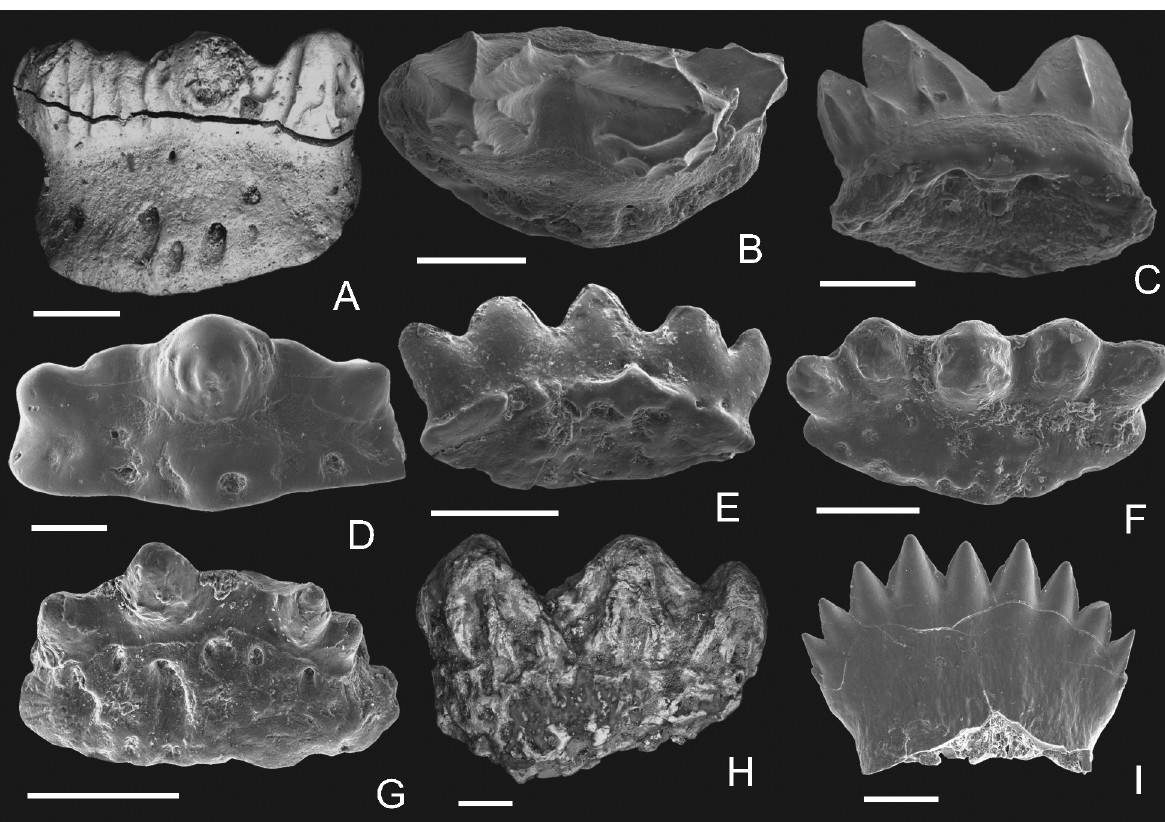
Fig. 4. Teeth of protacrodontids and Ageleodus from the Devonian and Carboniferous of Belarus. A – C , Protacrodus aequalis Ivanov, 1996. A, SPCG 101/10-2, lingual view, Krasnoselskaya-215 core, depth 3176–3184 m, sample 16a, Lower Famennian, Petrikov Regional Stage; B, C, PM SPU 82-9, B, occlusal and oblique labial views, 506 core, depth 241.6 m, sample 56b, Upper Famennian, Borovoe Regional Stage. D – F , Protacrodus sp. D, PM SPU 82-10, oblique lingual view, Berzhetsy-475 core, depth 166 m, sample 8, Lower Tournaisian, Upa Regional Stage; E, F, PM SPU 82-11, E, oblique labial and F, occlusal views, 331 core, depth 225–227 m, sample 2, Lower Tournaisian, Cherepet Regional Stage. G , H , Protacrodontidae indet. G, PM SPU 82-12, oblique lingual view, 441 core, depth 304–307 m, sample 30v, Lower Tournaisian, Malevka Regional Stage; H, SPCG 86/35-1c, labial view, Berdyzh-1 core, depth 230.8 m, sample 35, Givetian, Polotsk Regional Stage. I , Ageleodus sp., PM SPU 82-13, ?lingual view, 506 core, depth 241.6 m, sample 56b, Upper Famennian, Borovoe Regional Stage. Scale bars 200